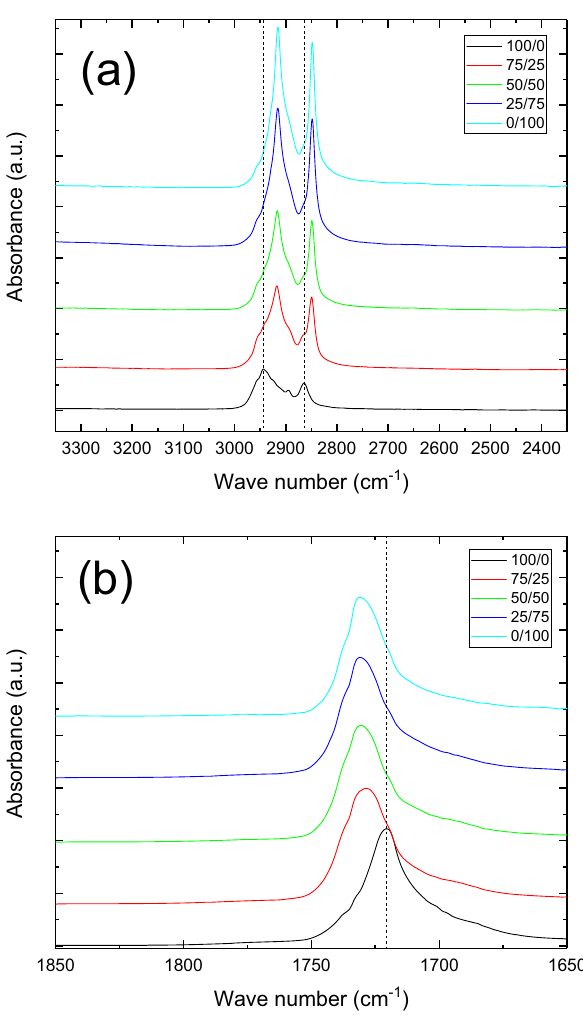
Figure 4: FTIR spectra of MW - assisted ROP copolyesters CL – PDL: ( a ) in the 3,300 – 2,400 cm − 1 range and ( b ) in the 1,850 – 1,650 cm − 1